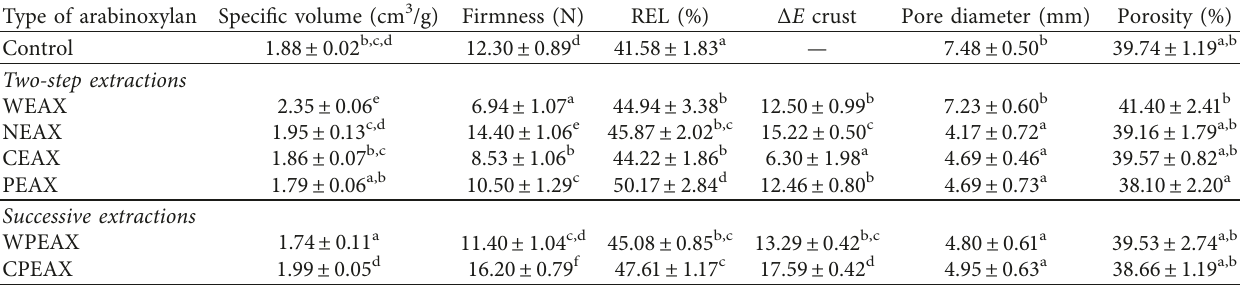
Table 4: Influence of differently extracted arabinoxylan on the technological properties of millet sourdough-breads 1 . Type of arabinoxylan Specific volume (cm 3 /g) Firmness (N) REL (%) Δ E